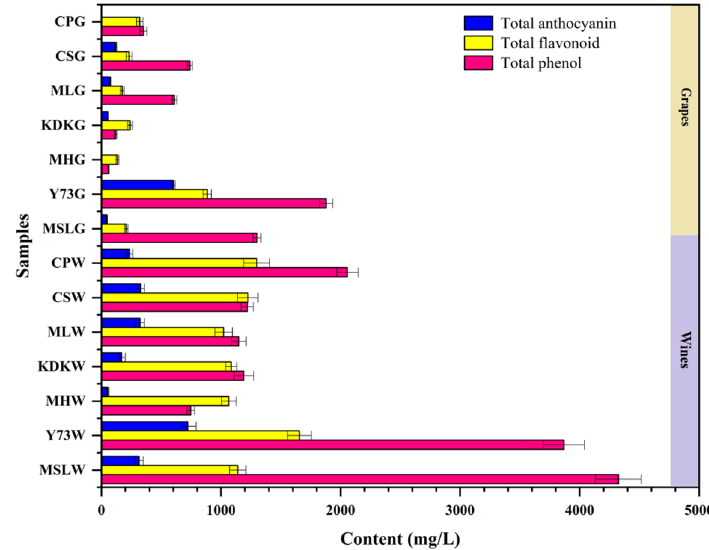
Figure 3. The content of total phenol, total flavonoid, and total anthocyanin of seven grape cultivars and corresponding wines ( p ≤ 0.05). Samples’ full names are as follows : MSL (Marselan), Y73 (Yan 73), MH (Muscat Hamburg), KDK (Kadarka), ML (Merlot), CS (Cabernet Sauvignon) and CP (Crimpose). Furthermore, G represents “grape” and W represents “wine”.